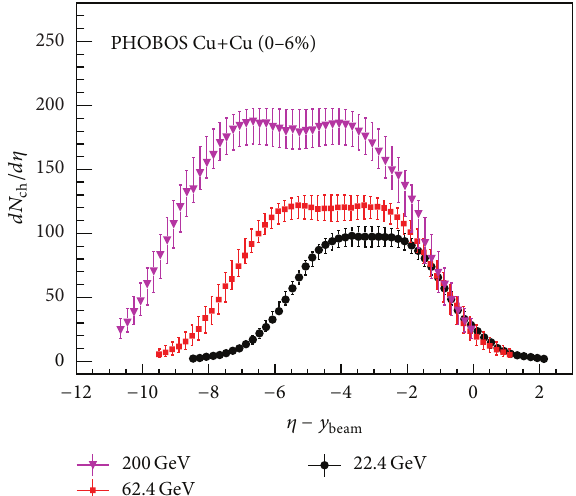
Figure 6: Charged particle multiplicity density normalized by participant pairs for Au+Au collisions at different energies, shown . in the rest frame of projectile by using 𝜂 󸀠 = 𝜂 − 𝑦 beam